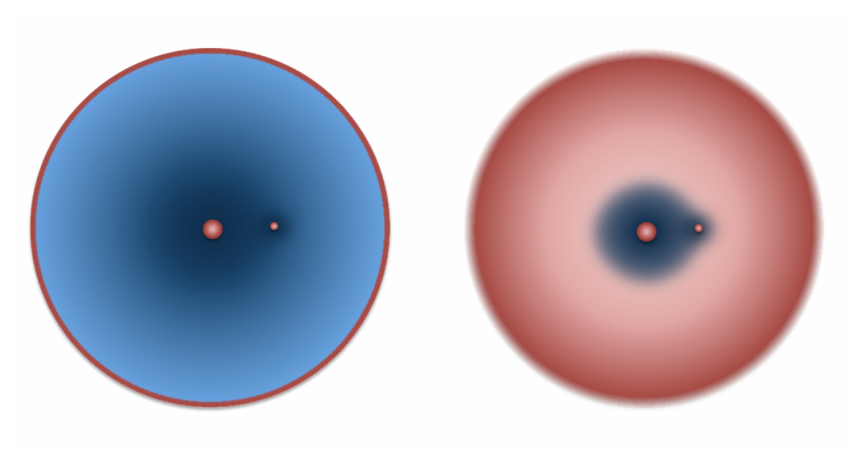
Figure 2: In AdS (left) the entanglement entropy obeys a strict area law and all information is stored on the boundary. In dS (right) the information delocalizes into the bulk volume. Only in dS the matter creates a memory effect in the dark energy medium by removing the entropy from an inclusion